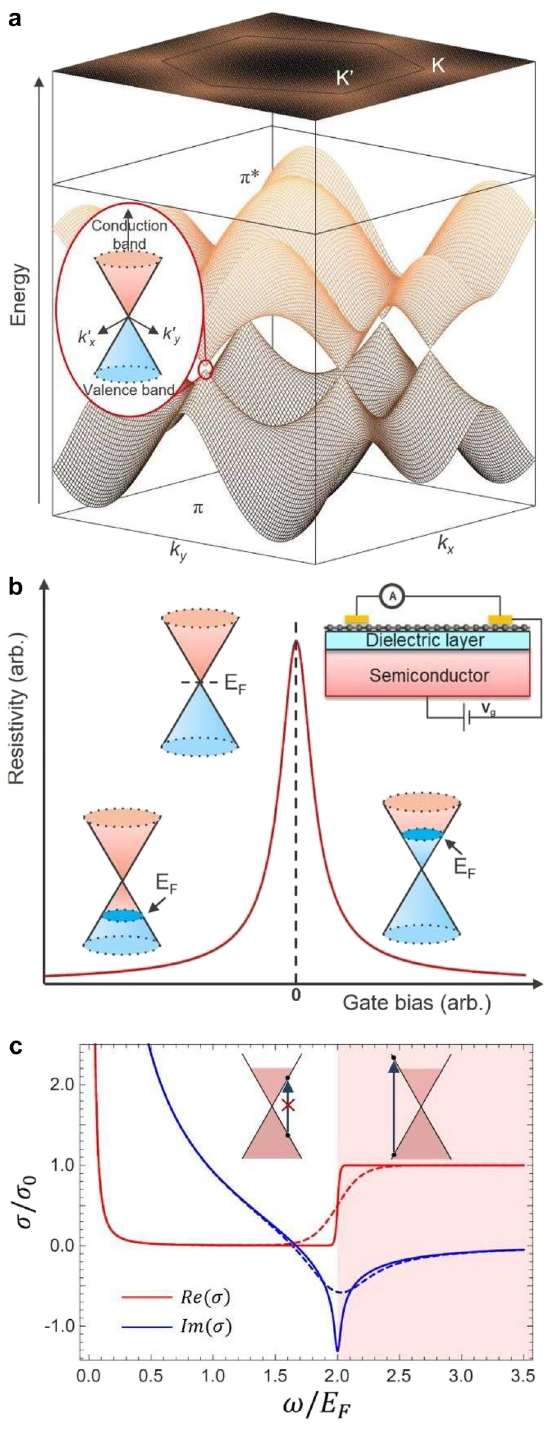
Figure 1: Electrical and optical properties of graphene. (a) Band structure of graphene. The top and bottom energy surfaces represent the conduction band ( π * band) and the valence band ( π band), respectively. Inset is the enlargement of the band structure neartheDiracpoint Κ 0 ,showingthelineardispersion.(b)Resistivity of single-layer graphene as a function of an external gate bias showingtheambipolarelectric fi eldeffect.Adaptedwithpermission